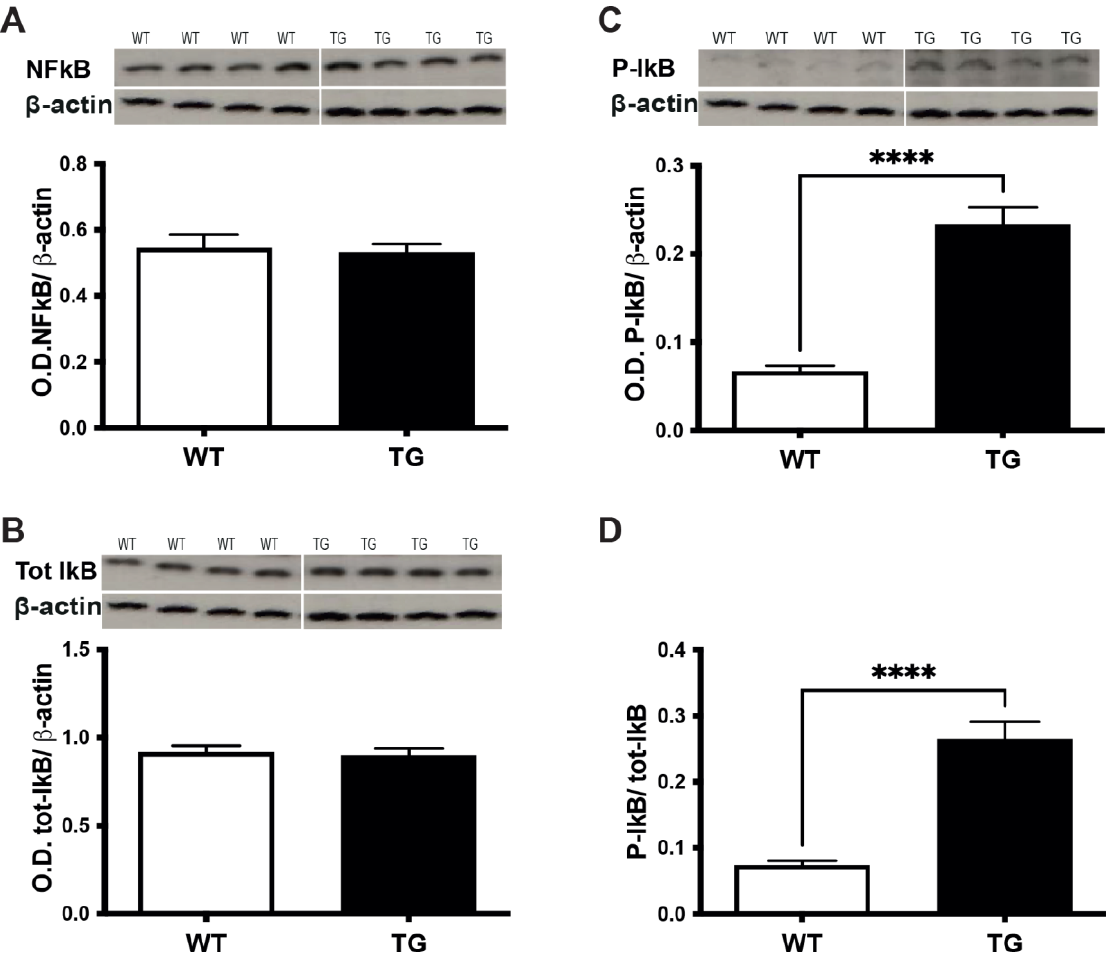
Figure 6. Assessment of TNFα signaling pathway in pre-symptomatic APP/PS1mouse retina. ( A ) Analysis of NFkB (WT n = 5:2F + 3M; TG n = 9:5F + 4M), ( B ) total-IkB (WT n = 9:4F + 5M; TG n = 9:4F + 5M) and ( C ) phospho-IkB protein (WT n = 9:4F + 5M; TG n = 9: 4F + 5M) expression by western blot. Representative western blot images are shown above the relevant quantification. All western blot images shown are from the same n = 4 TG and n = 4 WT mice aged 3 months out of a total n = 9 and n = 9 for TG and WT mice, respectively. Quantification was performed after normalization over β-actin, used as a loading control. ( D ) NFkB activation index as expressed by the ratio of phospho-IkB over total-IkB expression. **** p 0.0001.